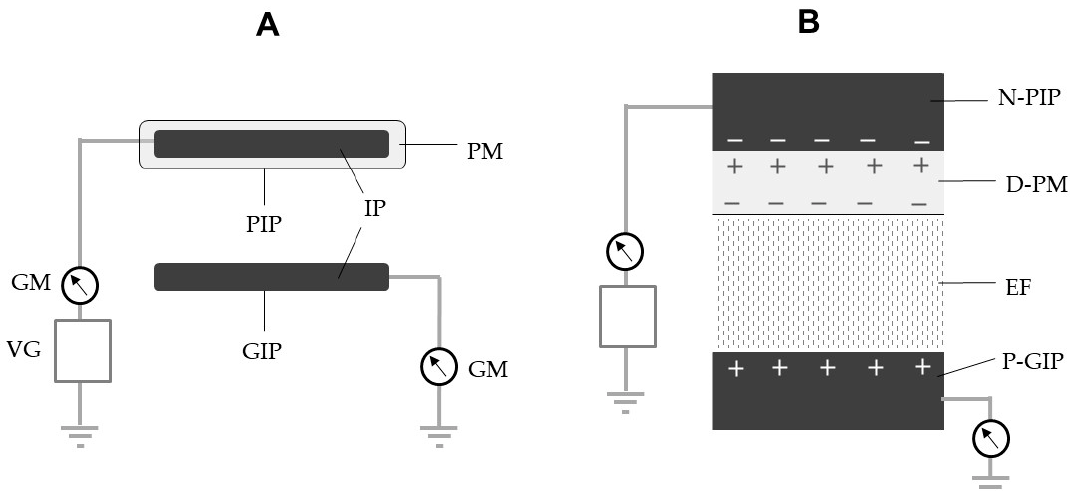
Figure 2. Schematic representation of ( A ) an electric field producer (EFP) and ( B ) dielectric polarization of a polyvinyl chloride (PVC) membrane used to insulate an iron plate, followed by electrostatic induction of a grounded iron plate paralleled with an insulated iron plate. D-PM, dielectrically polarized PVC membrane; EF, electric field; GIP, grounded iron plate; GM, galvanometer; IP, iron plate; N-PIP, negatively charged iron insulated iron plate; P-GIP, positively polarized grounded plate; PIP, PVC-insulated iron plate (charged conductor); PM, PVC membrane coating (insulator); VG, voltage generator.